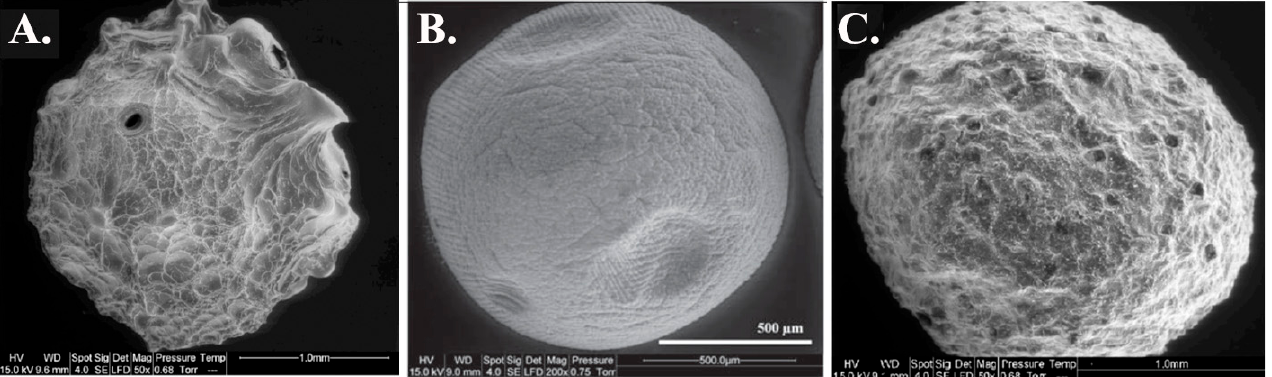
Figure 4. Morphological change of alginate and alginate-based adsorbents (grafting of amine function)—ESEM Images. ( A ). Alginate beads, ( B ). Alginate-urea, and ( C ). Alginate-PEI, from [75].